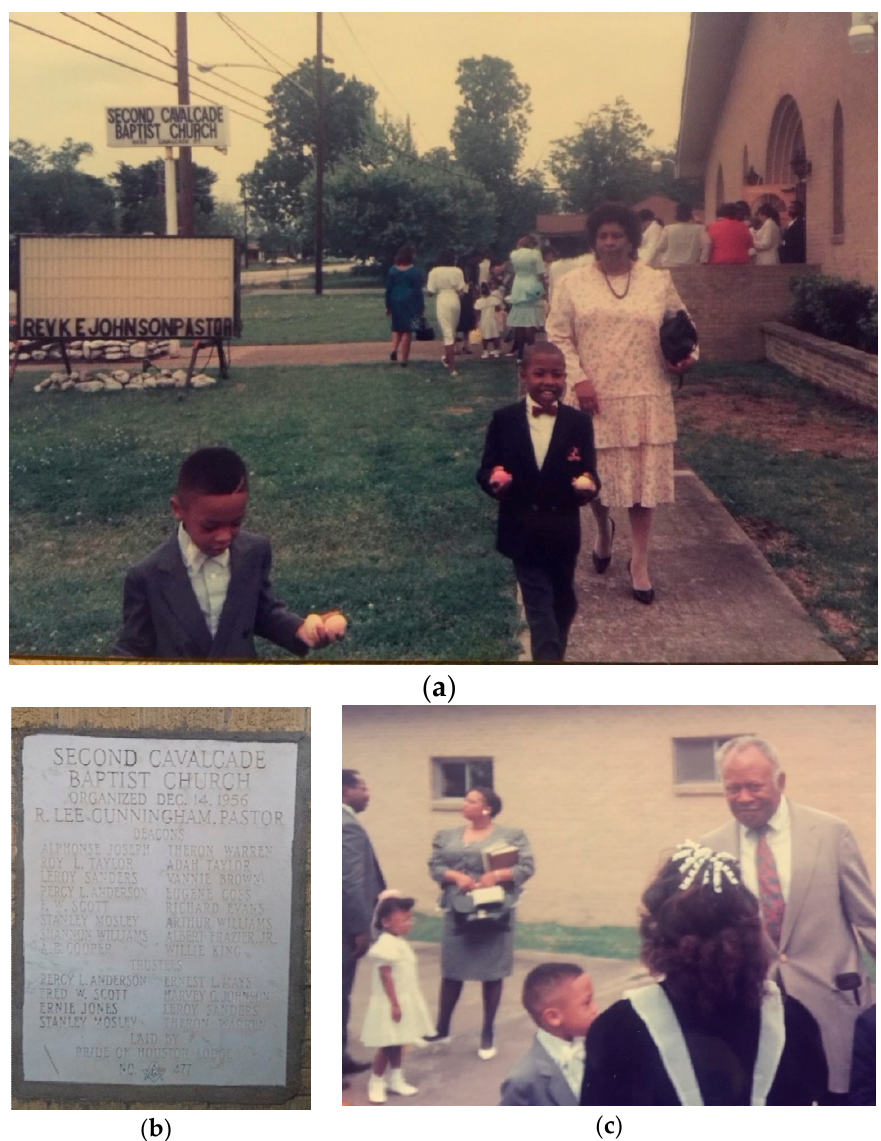
Figure 12. ( a ) Easter Sunday at Second Cavalcade Missionary Baptist Church. My brother and cousin with my grandmother, Emmola Frazier, not trailing too far behind; ( b ) Cornerstone of the church with my grandfather’s name on it; ( c ) My grandfather, Albert Frazier, Jr., and me with my cousin, Lonnie Hill. Photographs courtesy of the Frazier family.